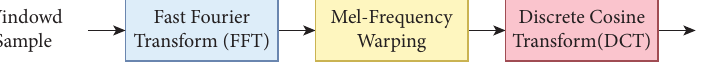
Figure 3: MFCC feature